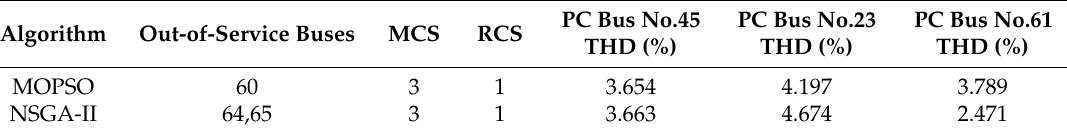
Table 16. Restoration plan through Non-Dominated Sorting Genetic Algorithm-II (NSGA-II) and Multi-Objective Particle Swarm Optimization (MOPSO) algorithms when the fault occurred between bus 56 and bus 57.